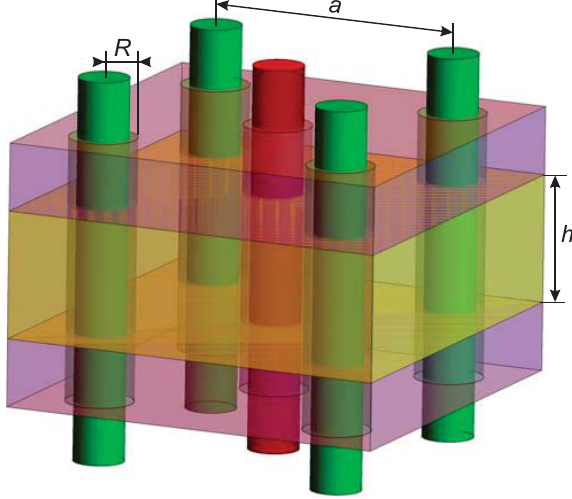
Figure 1. View of a square cell of the wire array. The semiconductor film is represented in orange. It is sandwiched between two insulating layers drawn in purple. The wires in green, located at the square vertices, are at the ground potential. The central wires in red are at the bias potential. R : wire radius, including the thickness of the insulating sheath; a : square-lattice parameter; h : film